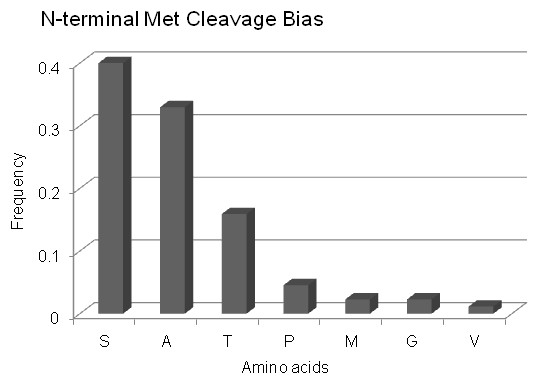
Experimental annotation of N-terminal methionine cleavage. The frequency of amino acid occurrence at position P1' reveals a clear preference for small amino acids at P1' in agreement with current N-terminal methionine cleavage rules.